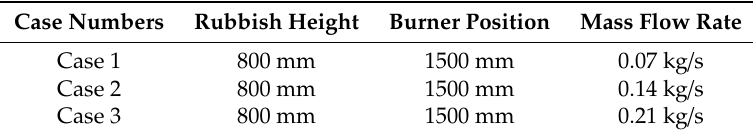
Table 5. Di ff erent mass flow rate of the cooling air for the incinerator.